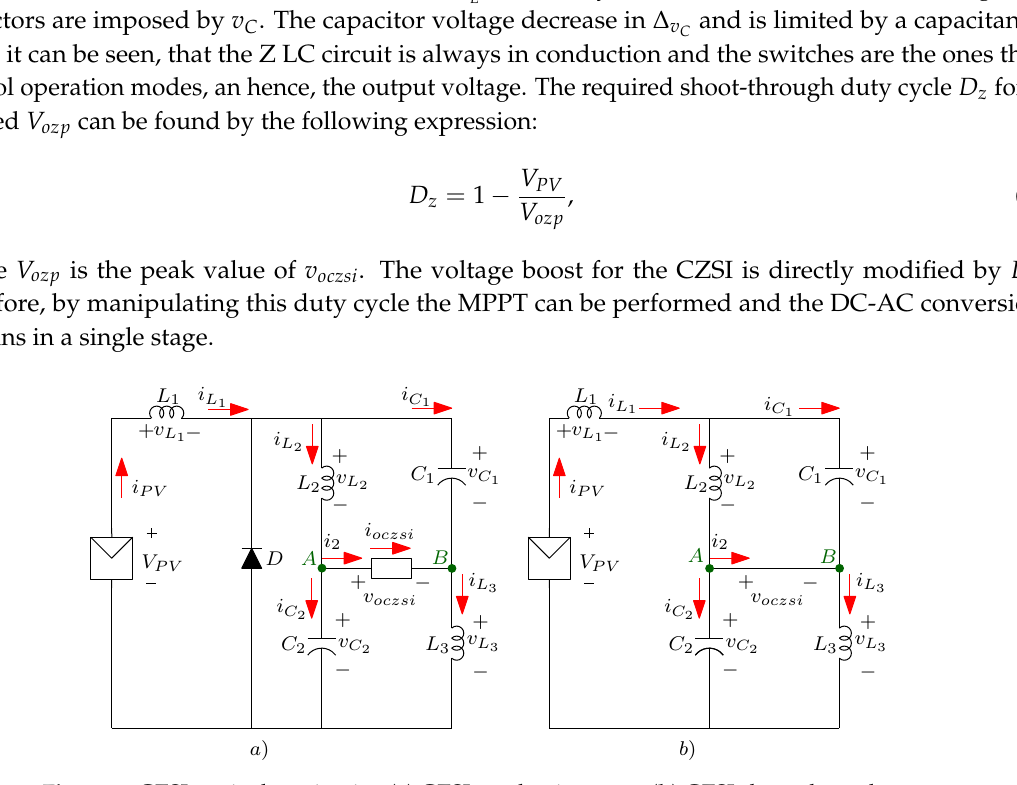
Figure 3. CZSI equivalent circuits: ( a ) CZSI conduction state, ( b ) CZSI shoot-through